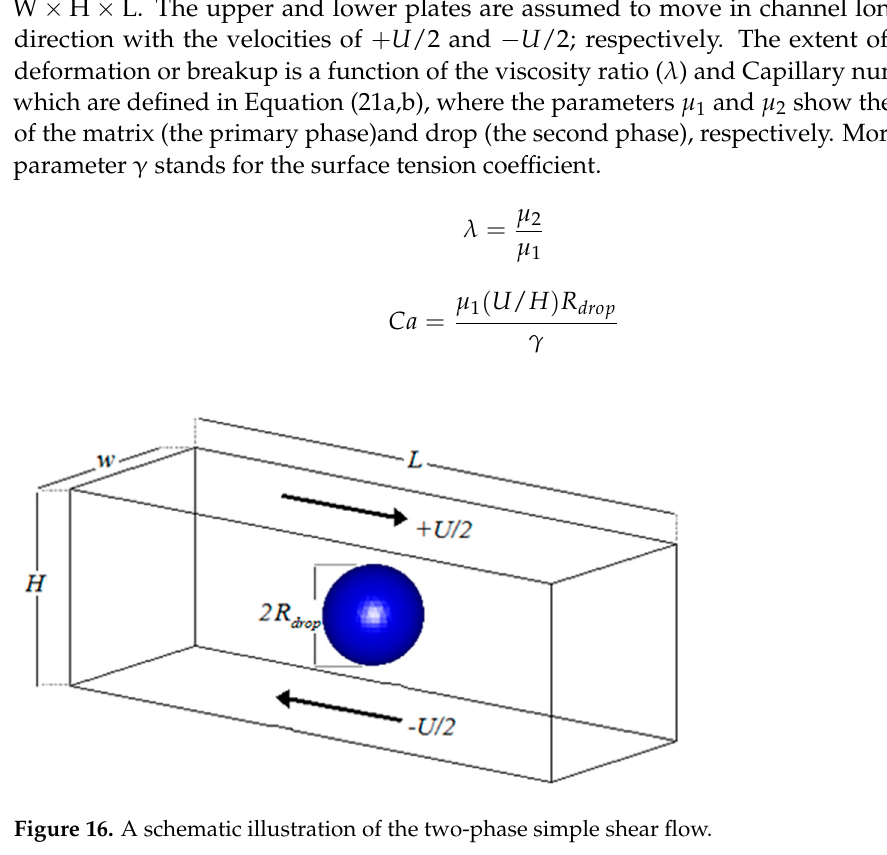
Figure 15: The interface shape in swirling flow vortex at t = 4 and t = 8 for unstructured meshes with different spacing. The values of the 𝜖 (cid:2869) norm is also presented.